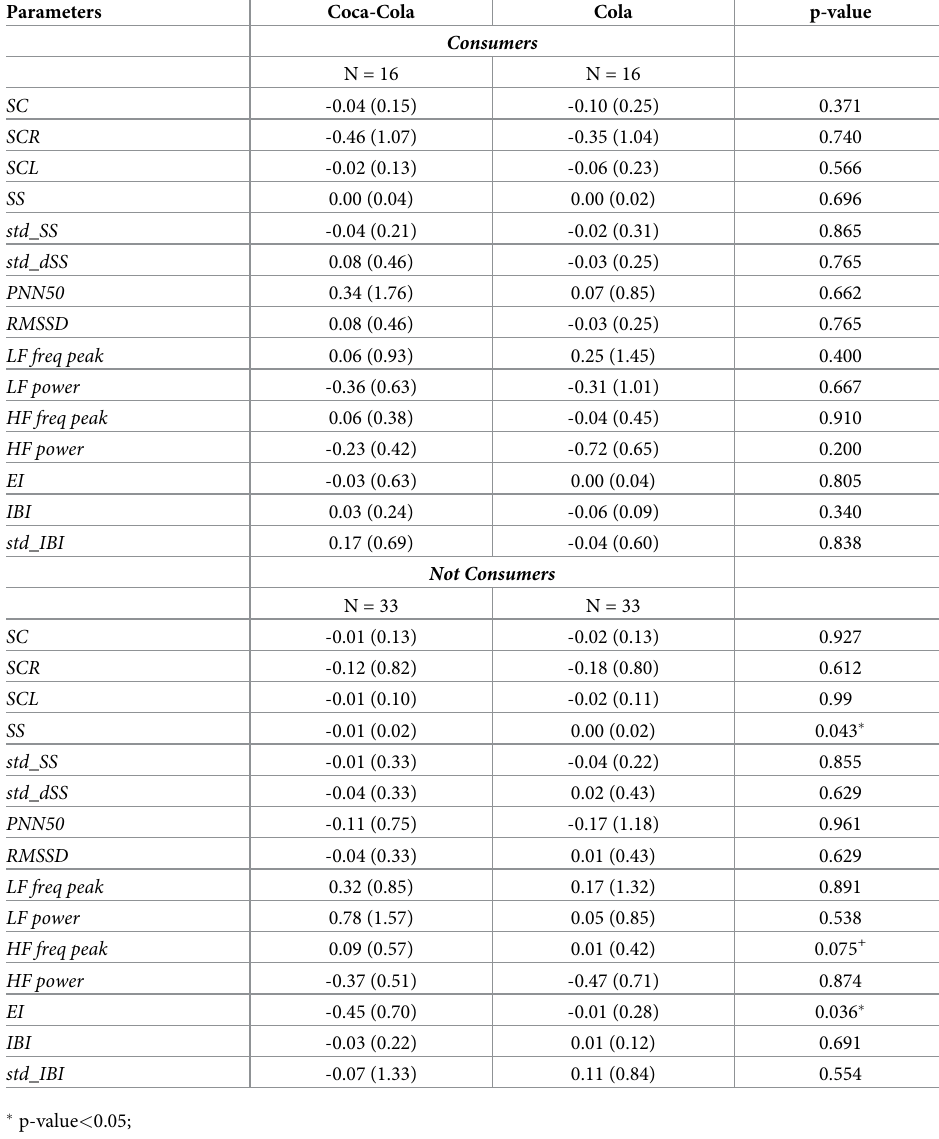
Table 6. Comparison of the beverages in the consumers/not consumers